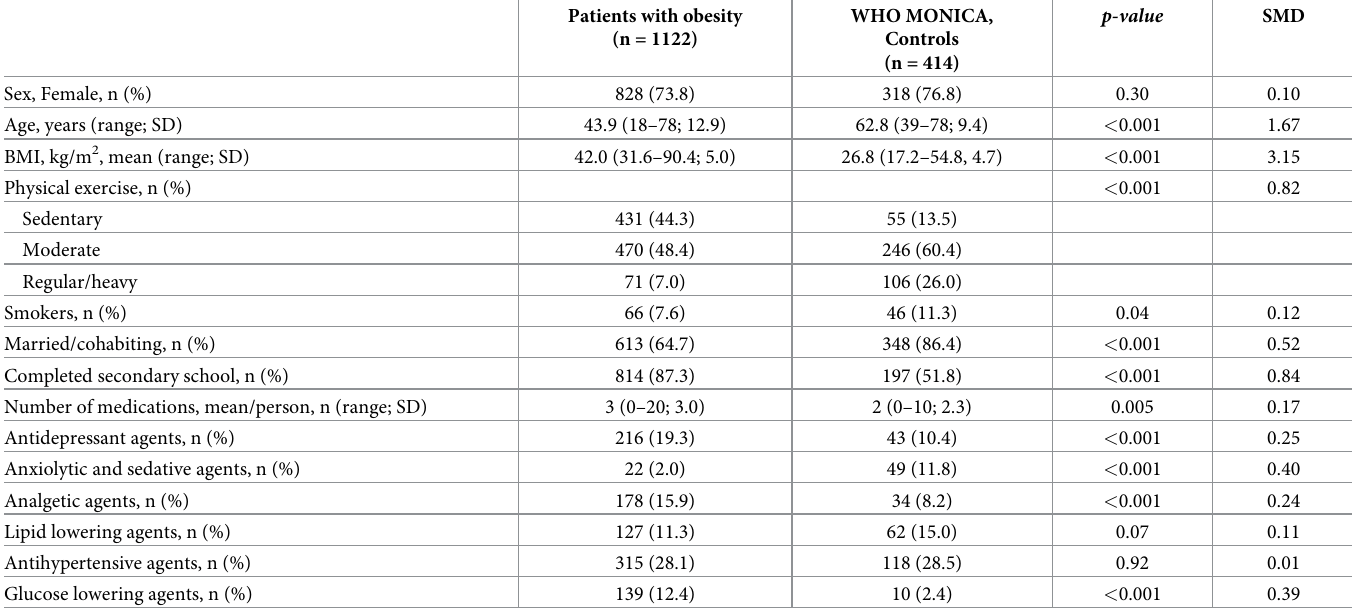
Table 1. Anthropometric and social background data, degree of physical activity, number of medications and data on those who used at least one prescription drug in people with obesity (BASUN) and the reference population from the WHO-MONICA study, Gothenburg, Sweden. Patients with obesity (n = 1122)